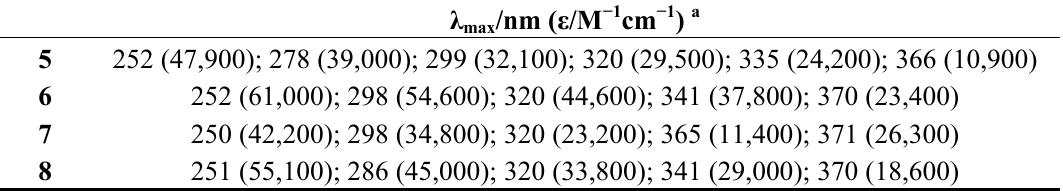
Table 1. Ground State Absorption Maxima and